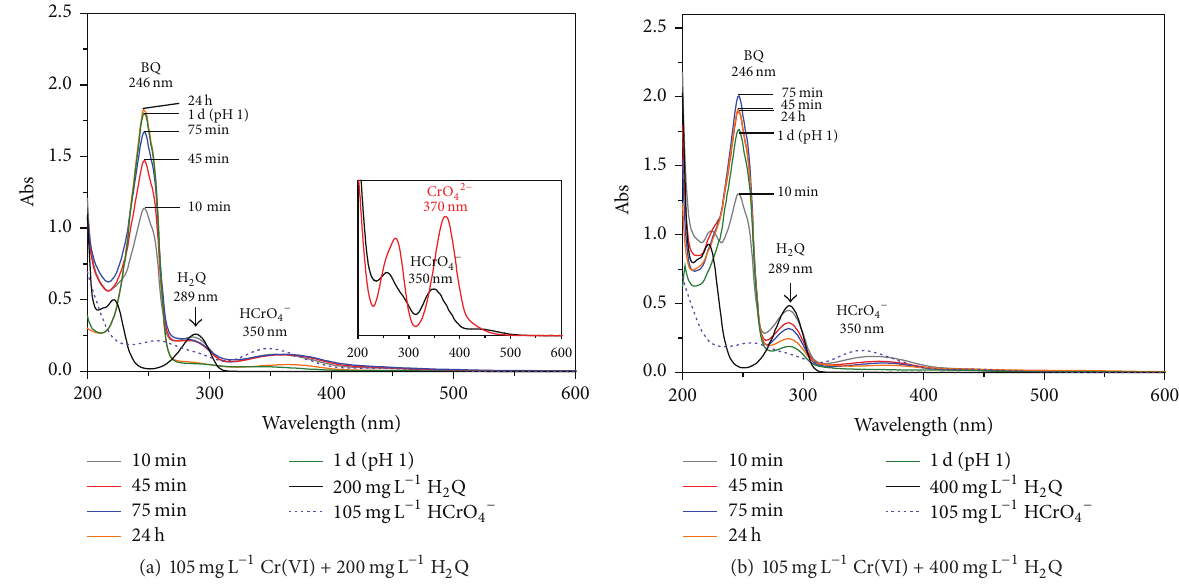
Figure 1: The UV-VIS spectra of the reaction products of 105 mgL −1 Cr(VI) with (a) 200 mg L −1 and (b) 400 mg L −1 H 2 Q at pH 3.0 and 25 ∘ C for 10, 45, and 75 min and 24 h, respectively. 1d (pH 1) indicated that the sample was obtained by mixing 200/400 mg L −1 H 2 Q and 105 mgL −1 Cr(VI) at pH 3.0 for 24 h, followed by the acidification treatment at pH 1.0 for 1 d. The insert in (a) indicated that the absorption peak of HCrO 4− at 350 nm was shifted to CrO 42− at 370 nm with an increase in pH.